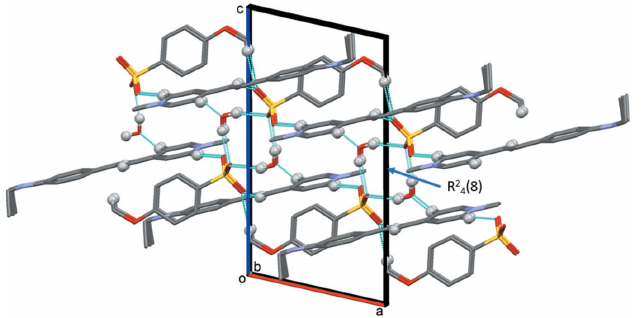
Figure 4 The crystal packing of salt (II), viewed along the b -axis, showing the hydrogen bonds (Table 1) as dashed lines. Only the H atoms (grey balls) involved in these interactions have been included.